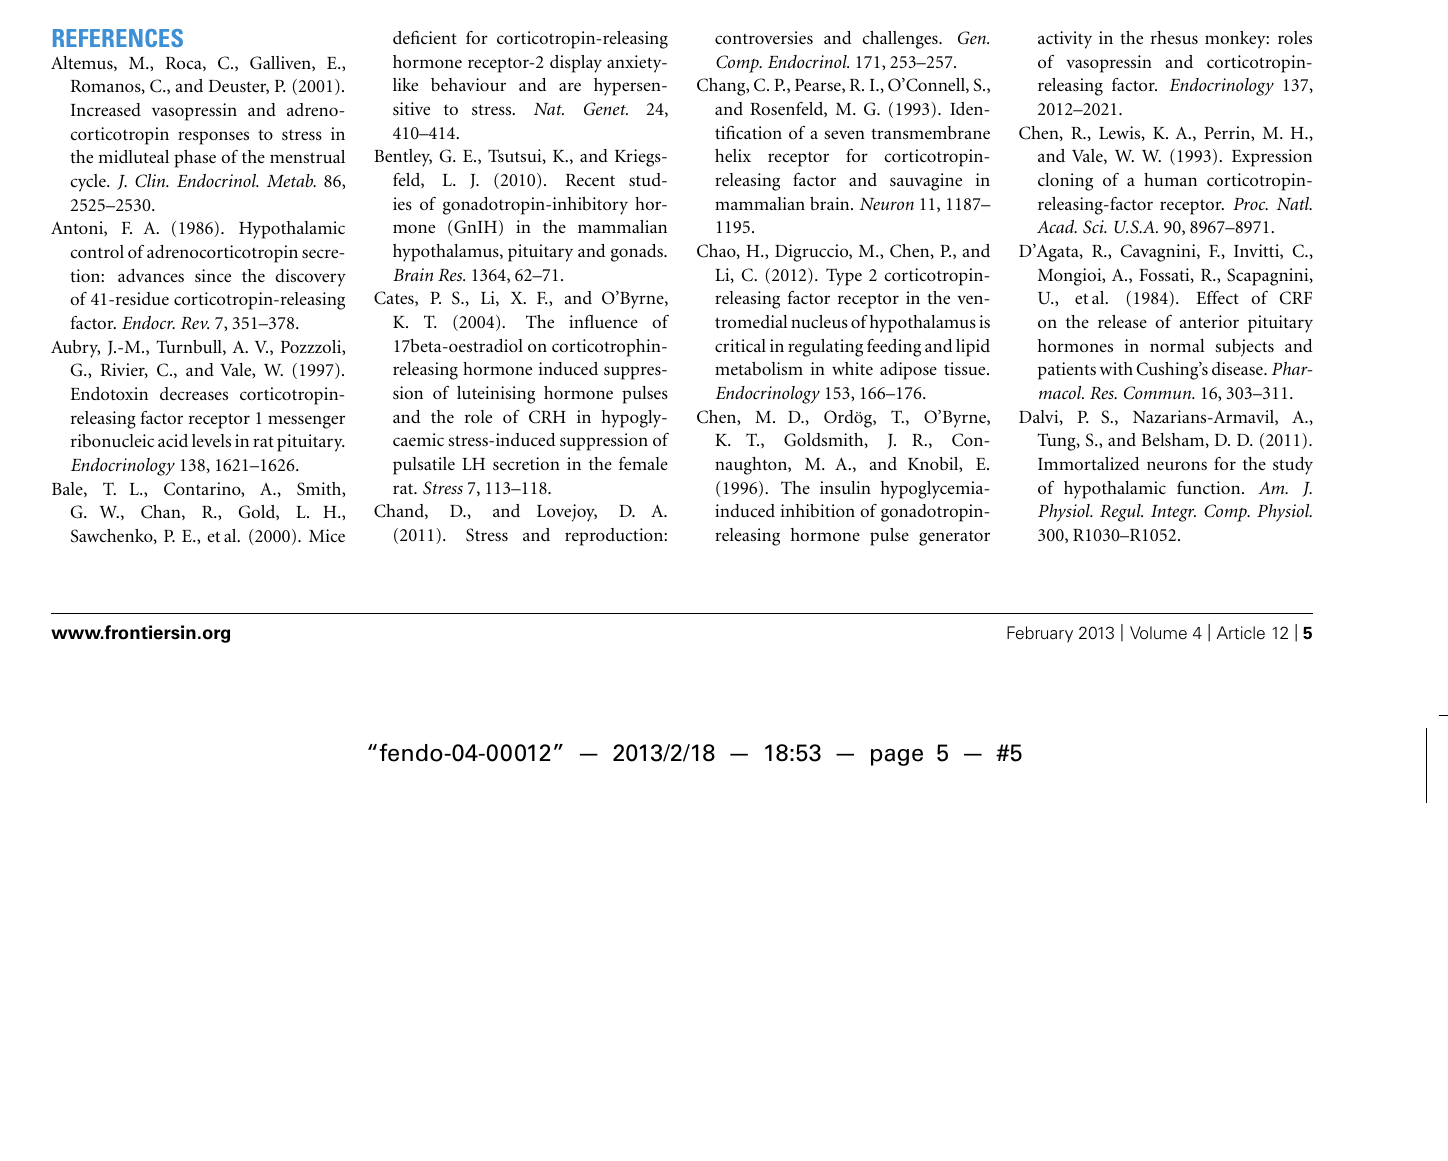
CRF inhibits the stress-induced suppression of the GnRH pulse generator and decreases GnRH mRNA levels via the CRF 1 receptor in the hypothalamus. The CRF 2 receptor may also be involved in the regulation of